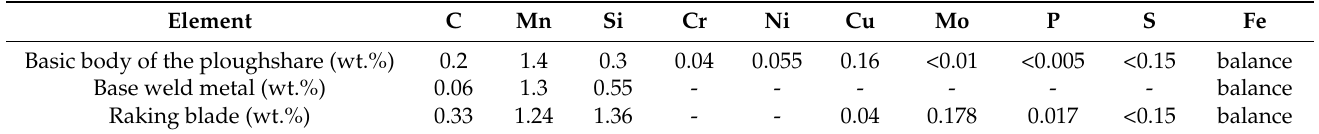
Table 2. Chemical composition of the individual parts of the original ploughshare.